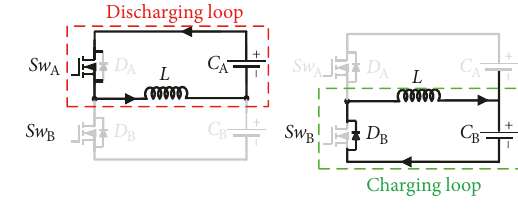
Figure 2: The principle of the equalizer.